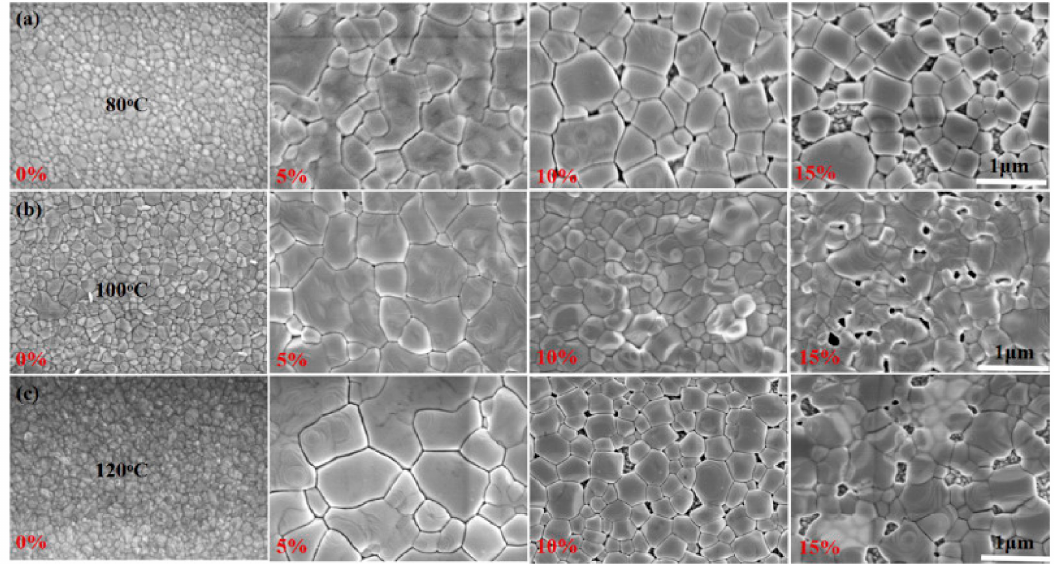
Figure 5. Field-emission scanning electron microscopy image of the perovskite doped with (from left to right) 0%, 5%, 10%, 15% Zn annealed at 80 ◦ C ( a ), 100 ◦ C ( b ) and 120 ◦ C ( c ). MA(Pb:Zn)I 3 . Figure reprinted with permission from, Mater. Today Energy 2017 , 5 , 205–213, Reference